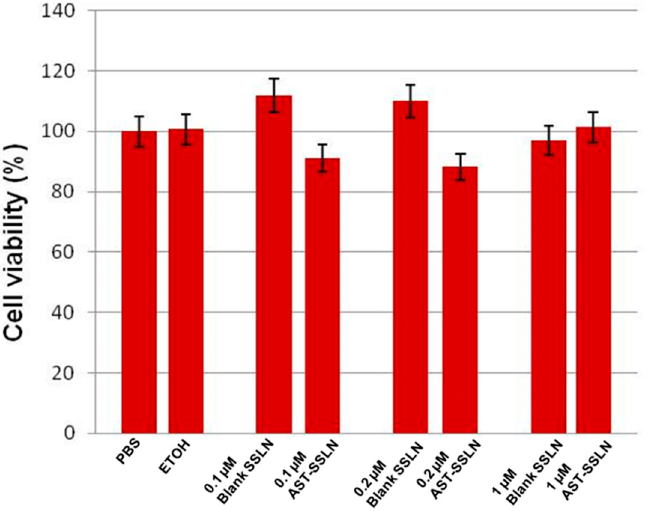
Figure 7. Percentage of cell viability in OECs exposed to 0.005% of PBS (phosphate buffer saline solution), 0.005% ETOH (ethanol), Blank-SSLN and AST-SSLN (0.1, 0.2, and 1 µ M) for 24 h. All the values shown represent the mean ± S.D. of three separated experiments performed in triplicate.